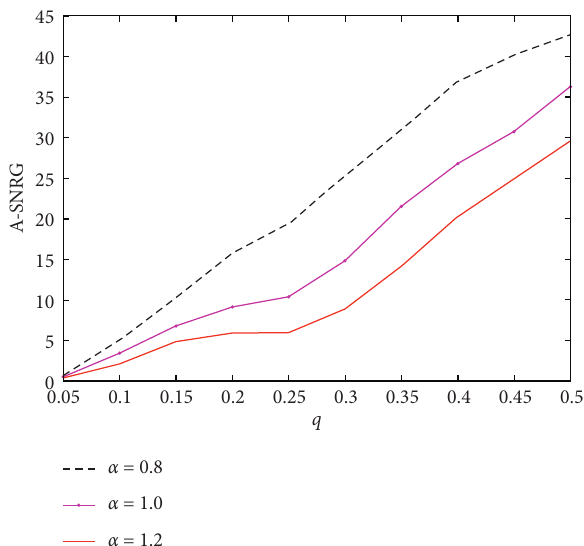
Figure 11: A-SNRG of SR with asymmetric width of potential well as a function of potential function parameter q